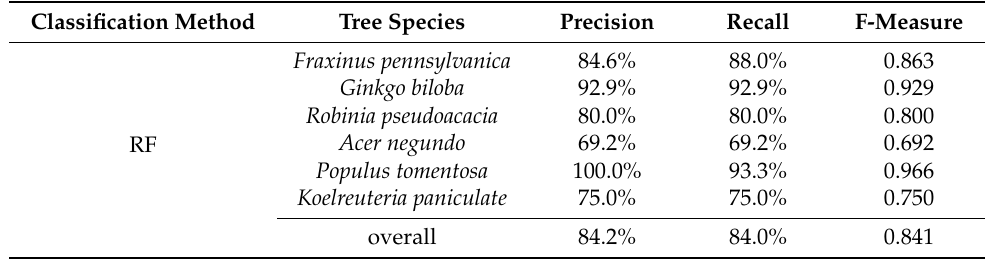
Table 6. Classification results using combined